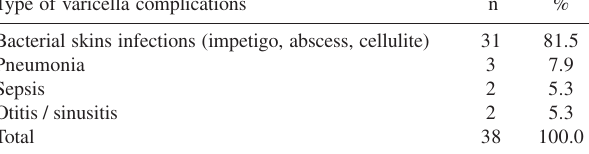
Table 4 - Varicella complications.